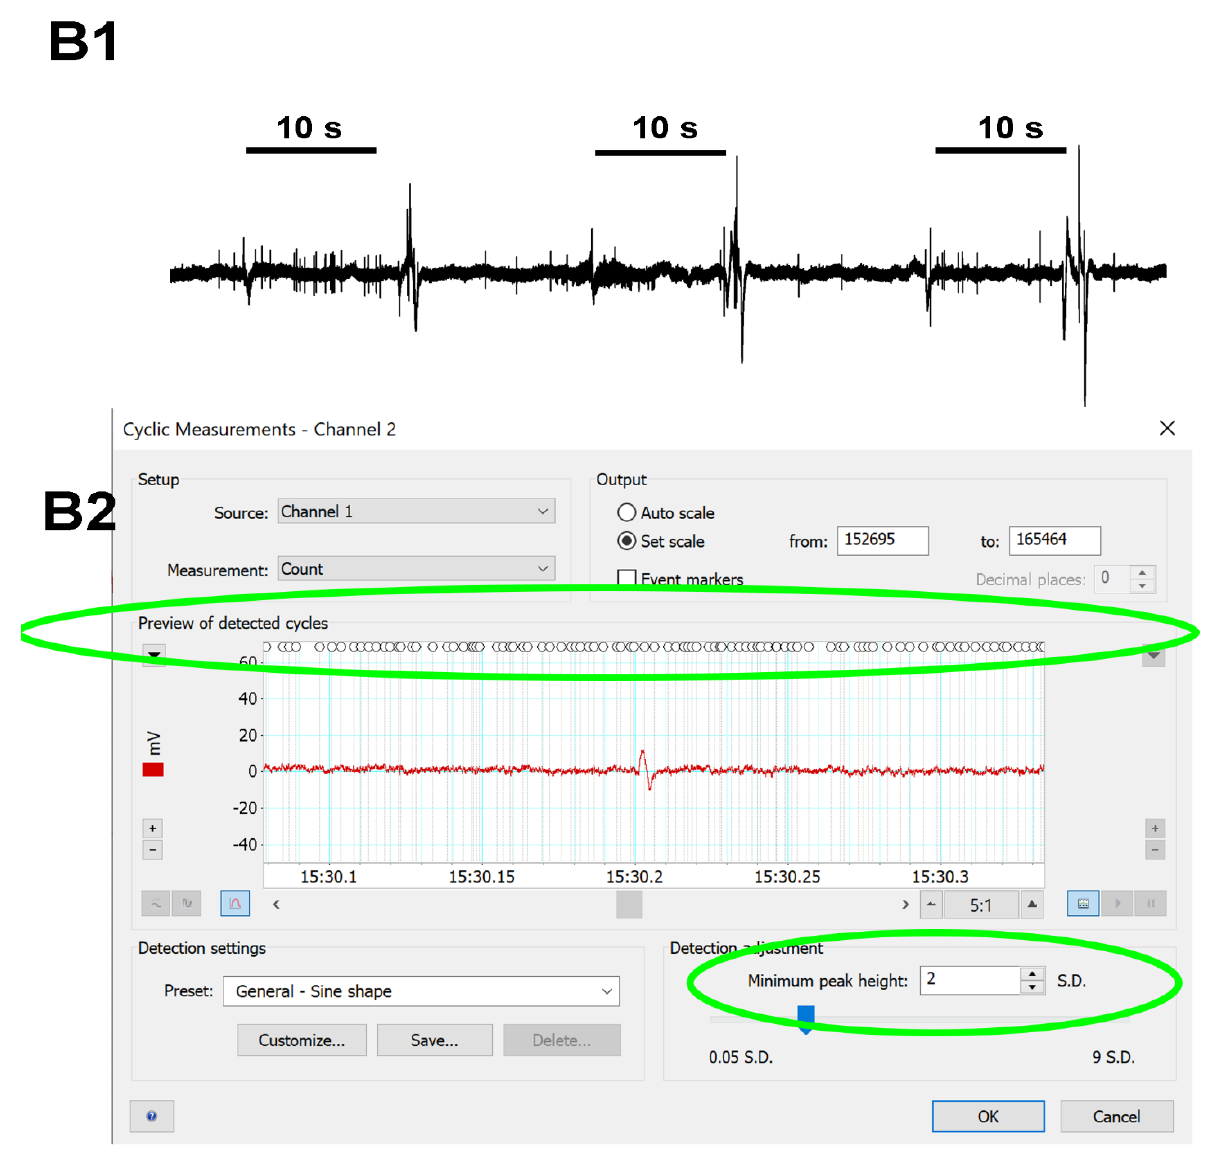
Figure A3. Analysis of data with the same automated measure. Two traces are provided: three trials in saline ( A1 ) and the three trials in doxapram after 5 min of incubation ( B1 ). The automated analysis is set to 2 SD (standard deviations of the mean in the traces; see small green ellipse in ( A2 , B2 )) for both ( A1 , B1) , but it produces differences in what is detected, as indicated in the large green ellipse in ( A2 , B2 ). The open circles inside the ellipse indicate what deflections in the trace are counted as spikes. Since there is little neural activity in ( B1 ), the noise of the trace is being detected as spikes, producing an artificially high number of spikes.